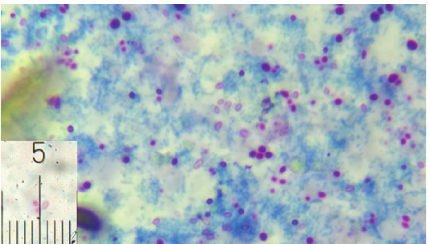
Figure 10: Microsporidial spores stained reddish pink with hori- zontal stripe measuring 1.9 𝜇 m (inset) on modified acid-fast stain, under oil immersion.